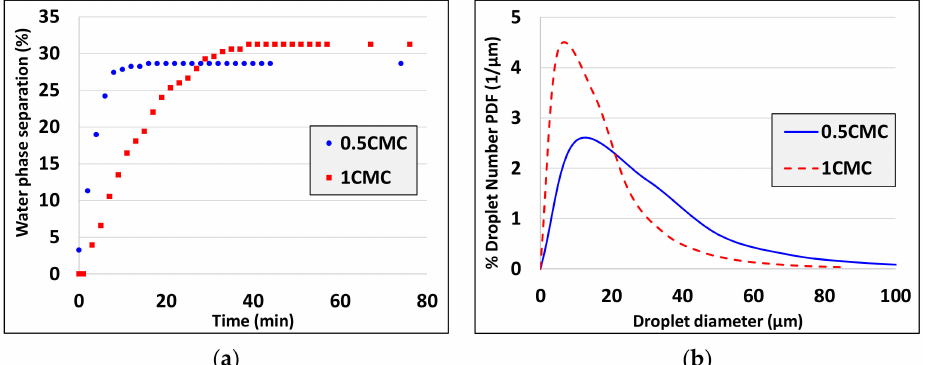
Figure 6. E ff ect of surfactant concentration C SDS on ( a ) water phase separation and ( b ) droplet size distribution of emulsions (t n = 2 min, ϕ = 0.5 and f = 10 Hz; Piston 1, 0.5 CMC: d av = 23.3 µ m, 1 CMC: d av = 13.5 µ m, 0.5 and 1 CMC: d min = 1.7 µ